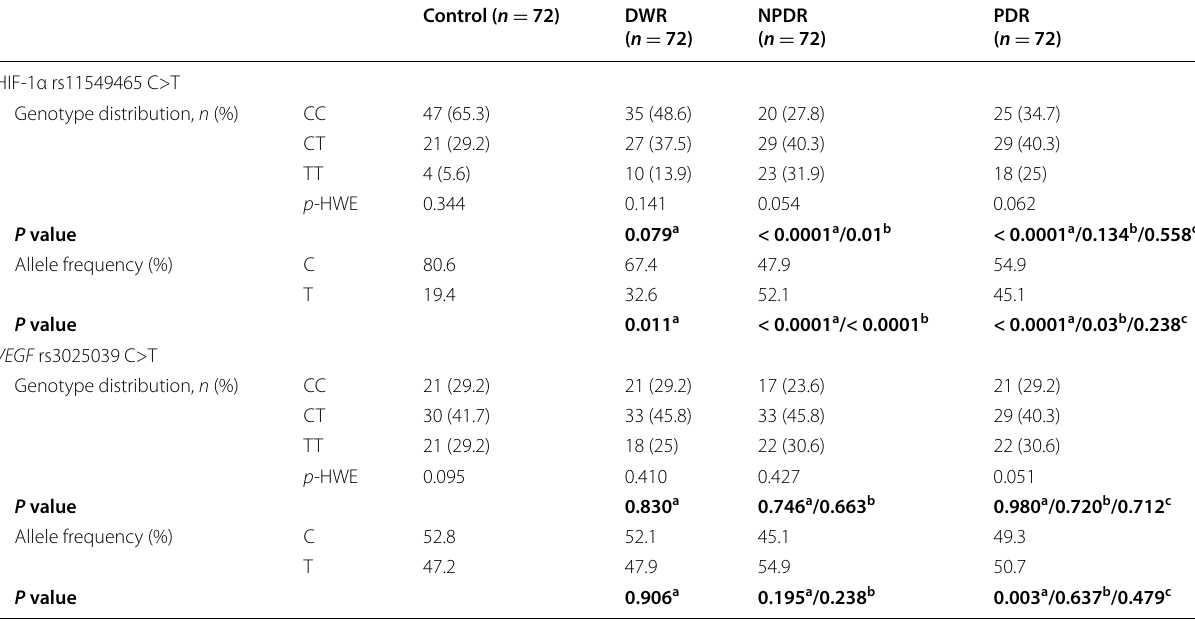
Data are expressed as frequencies